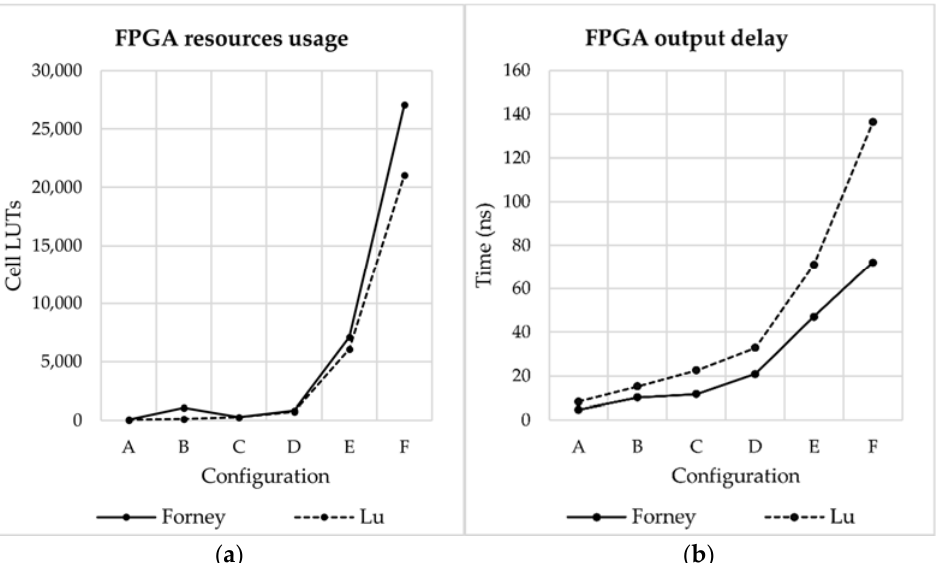
Figure 11. Graphical representation of the results of Table 4. ( a ) FPGA implementations resources’ usage in terms of cell look ‐ up tables (LUTs), ( b ) FPGA implementations’ output delay.